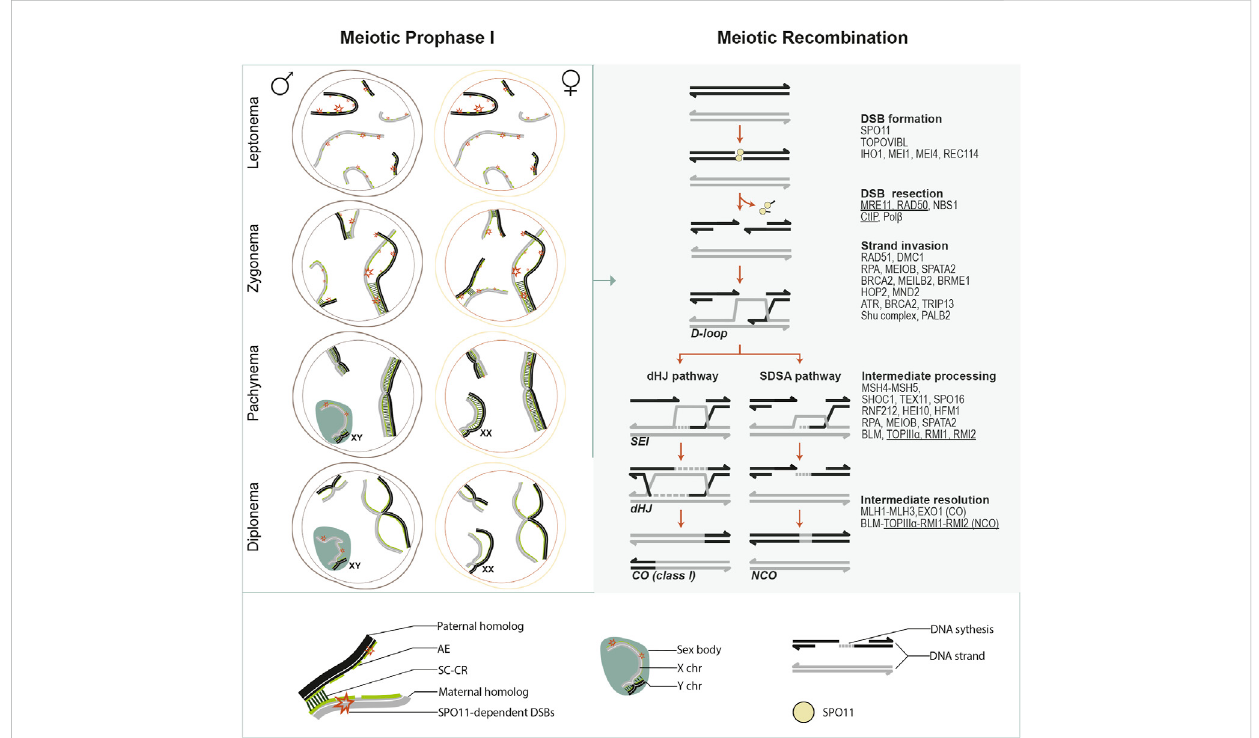
Meiotic prophase I overview. This schematic illustrates chromosome dynamics during meiotic prophase I in spermatocytes and oocytes (left panel) andthemeioticrecombinationpathway(rightpanel).Leftpanel,inmeioticprophaseI,eachpaternal(black)ormaternal(grey)homologouschromosome isorganizedaroundachromosomalaxis.Duringleptonema,axialelements(AEs)developforeachchromosome,andprogrammedSPO11-inducedDSBs aregeneratedasrecombinationinitiates.Duringzygonema,synapsisinitiatesbetweenpairedhomologs.ThenitspreadsalongwiththeentireAEsas the SC central region (CR) proteins (consisting of the transverse fi laments (TFs) and the central element (CE)) are installed between the AE. AEs are then designated as lateral elements (LEs) of the SC. In the meantime, DSBs are gradually repaired as recombination progresses. By pachynema, homologous chromosomes are fully synapsed, except for the heteromorphic X and Y chromosomes in the spermatocytes, which synapse only in a short pseudoautosomal region and form a transcriptionally silent chromatin compartment known as the sex body. By the end of pachynema in spermatocytes orduringlatepachynema/earlydiplonemainoocytes,meioticrecombinationcompletesasDSBsonautosomesareallrepaired,andcrossovers(COs)are generated. During diplonema, the CR is disassembled, and homologous chromosomes are only held together at the CO sites (chiasmata). From diplonema, spermatocytes progress to metaphase I, completing meiotic divisions without interruption. In contrast, oocytes arrest at the dictyate stage untilmeioticresumptionafterpuberty.Rightpanel,severalmajoreventsandcriticaltransitionsoccurduringmeioticrecombination.Mammalianproteins that are, or are predicted (underlined) to be, involved in each event are listed. SPO11 catalyzes DSB formation in association with its accessory proteins. DSB ends are further resected through a series of nucleolytic activities mediated by the MRN complex (MRE11- RAD50-NBS1) and others. As a result, a short oligonucleotide covalently attached to SPO11 (SPO11 oligo) is released, and 3 ′ ssDNA tails are generated, which are immediately coated by ssDNA binding proteins (such as RPA, MEIOB, SPATA22, etc. ). Recombinases DMC1 and RAD51 assemble at resected 3 ’ ssDNA tails, promotedby recombination proteins such asMEILB2, BRCA2, BRME1, etc. RAD51and DMC1 coated ssDNAare stabilized byHOP2-MND1 andengageinhomologysearch and strand exchange, resulting in D-loop formation. The repair can proceed by either a double Holliday junction (dHJ) pathway or synthesis-dependent strand annealing (SDSA). ZMM proteins and other factors control this by processing and stabilizing the recombination intermediates. In the dHJ pathway, D-loops are further stabilized by MutS γ homologs (MSH4 and MSH5), and the second end of the DSB is captured to form a dHJ, requiring